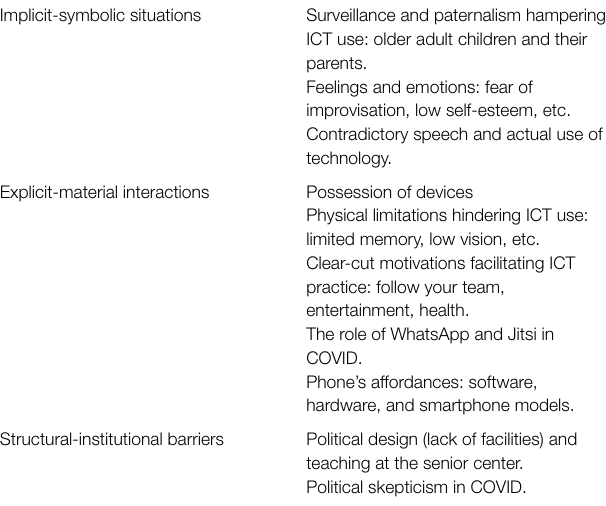
TABLE 3 | Summary of the dimensions. Implicit-symbolic